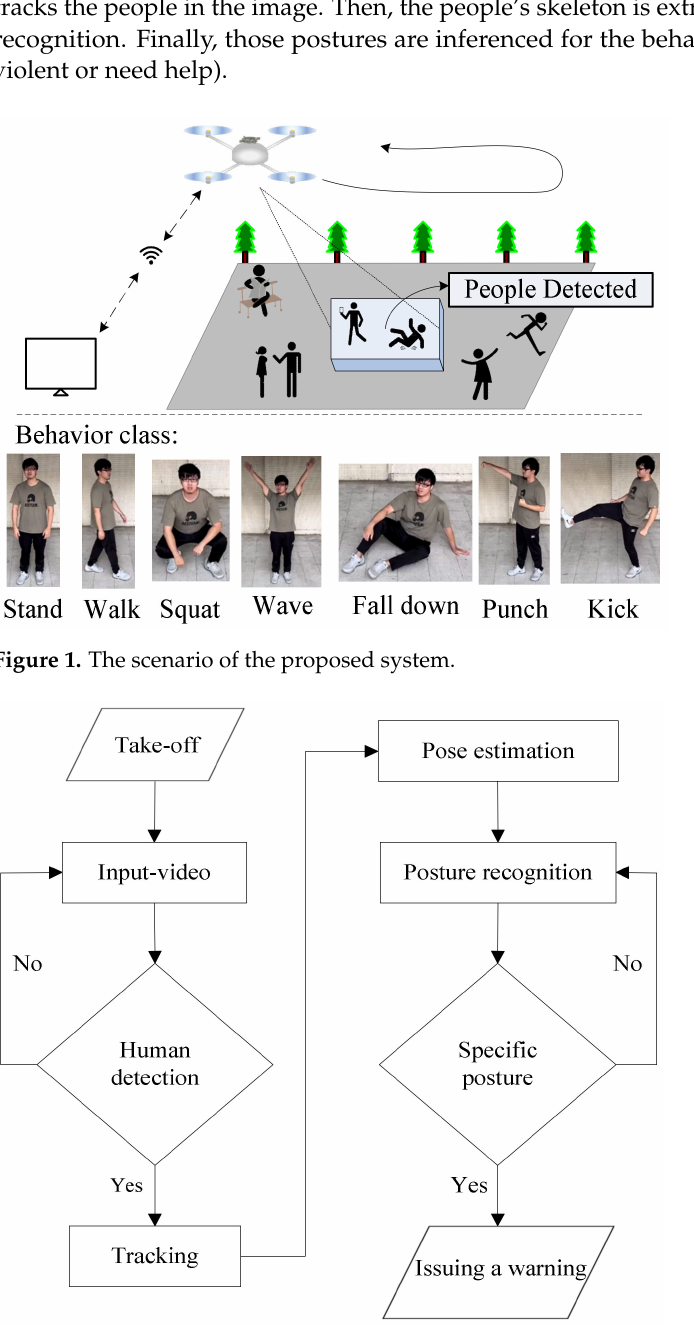
Figure 2. The flowchart of proposed